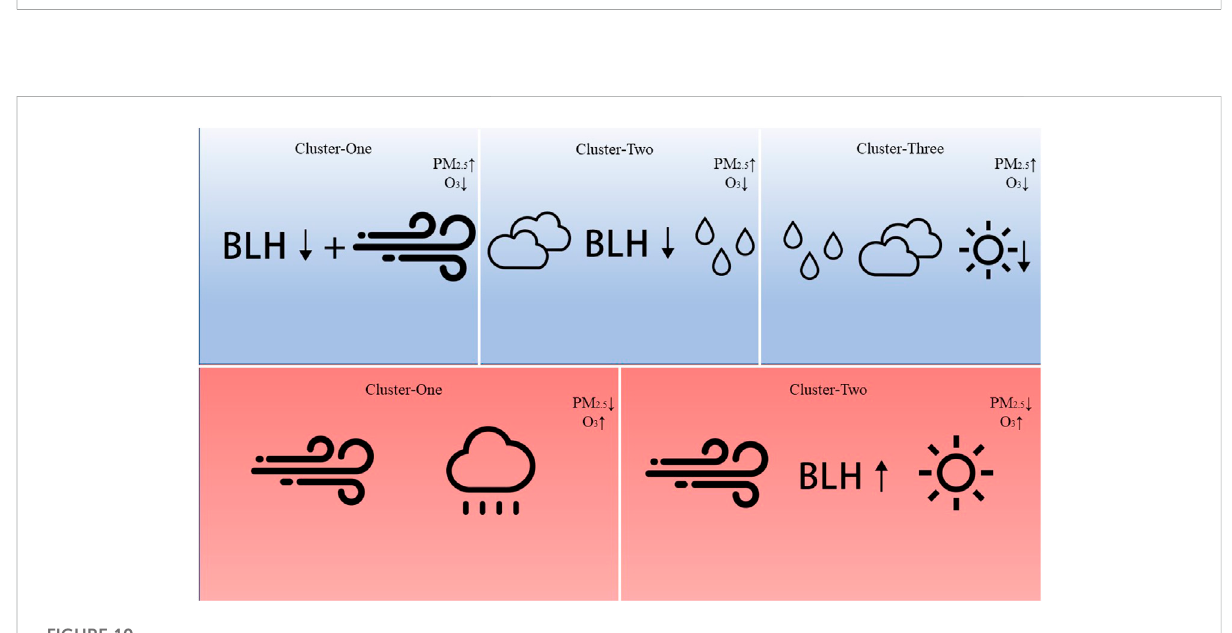
FIGURE 10 Diagram of the impacts of meteorology on both the O 3 and PM 2.5 concentrations in Shanghai during seesaw